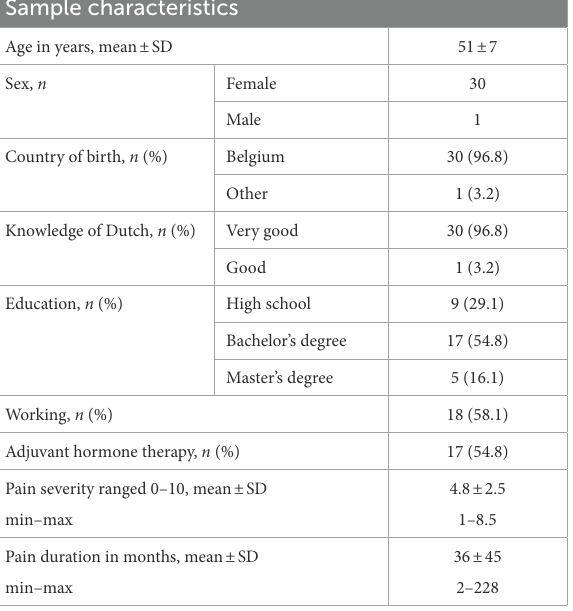
TABLE 1 Sample characteristics. Sample